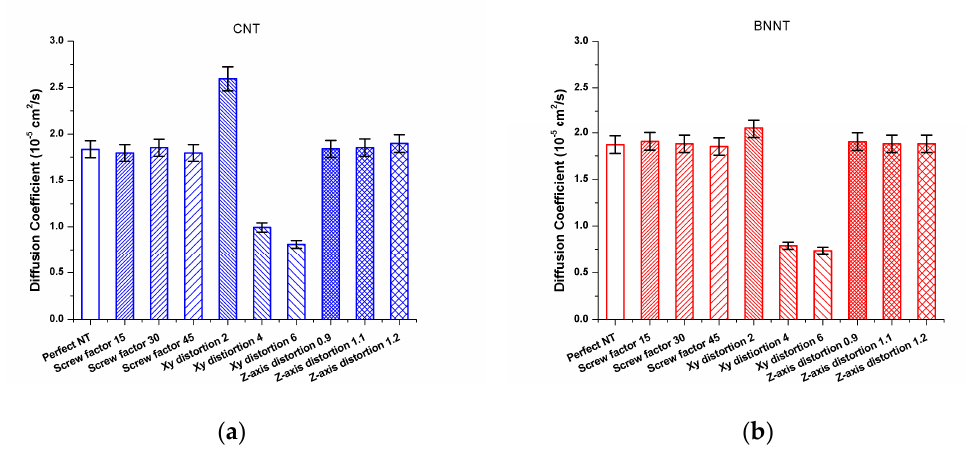
Figure 7. Pressure dependence of diffusion coefficient in perfect and different types of deformed nanotubes: ( a ) carbon nanotube (CNT) and ( b ) boron nitride nanotube (BNNT).